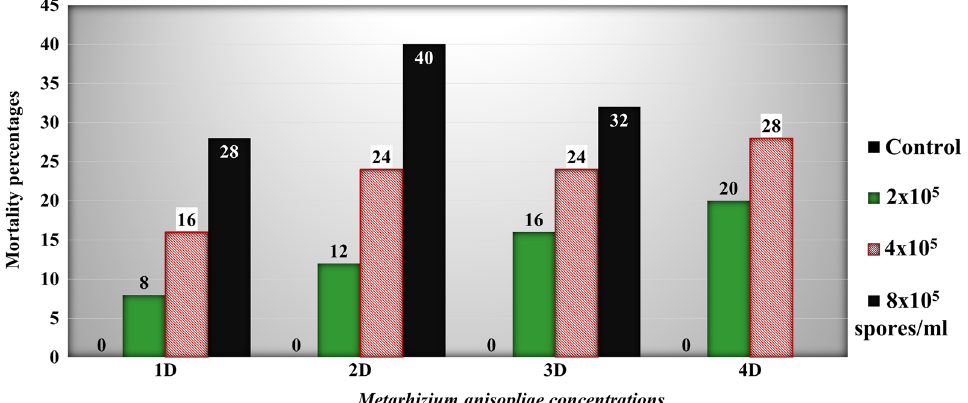
Fig. 2 Daily mortality of F1 5th instar Agrotis ipsilon larvae by different concentrations of Metarhizium anisopliae . Values represent the mean of 6 replicates each of 4